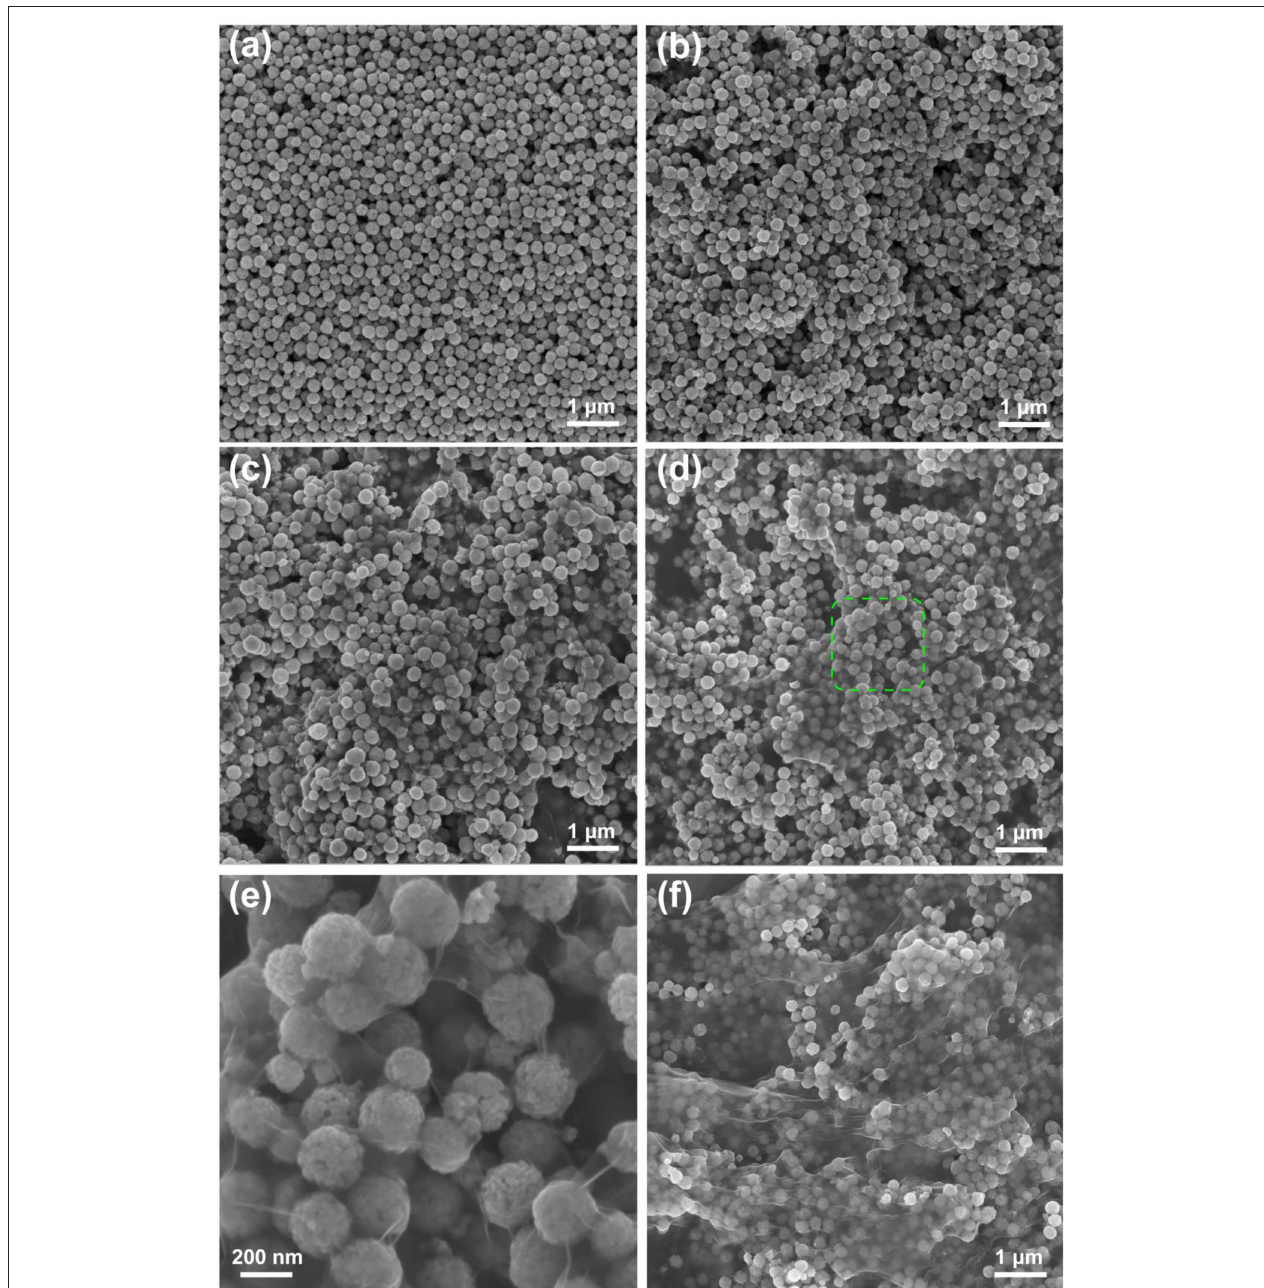
FIGURE 1 | The SEM images of (a) pure Fe 3 O 4 , (b) 3wt%-Fe 3 O 4 @GO, (c) 6wt%-Fe 3 O 4 @GO, (d) 10wt%-Fe 3 O 4 @GO, (e) enlarged view of 10wt%-Fe 3 O 4 @GO, (f)